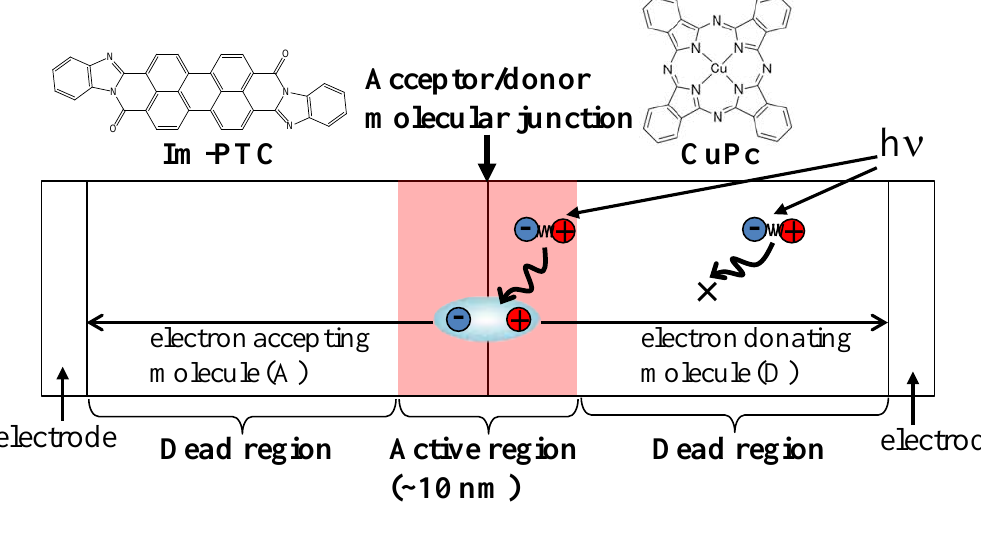
Figure 3. Schematic illustration of a two-layer cell composed of perylene pigment (Im-PTC) acting as an acceptor molecule (A) and copper phthalocyanine (CuPc) acting as a donor molecule (D). Photocurrent is generated only in the active region (shaded red) close to the heterojunction and all other parts of organic films act as a dead